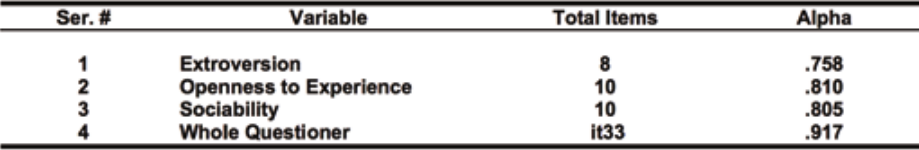
Table 5: Reliability coefficient